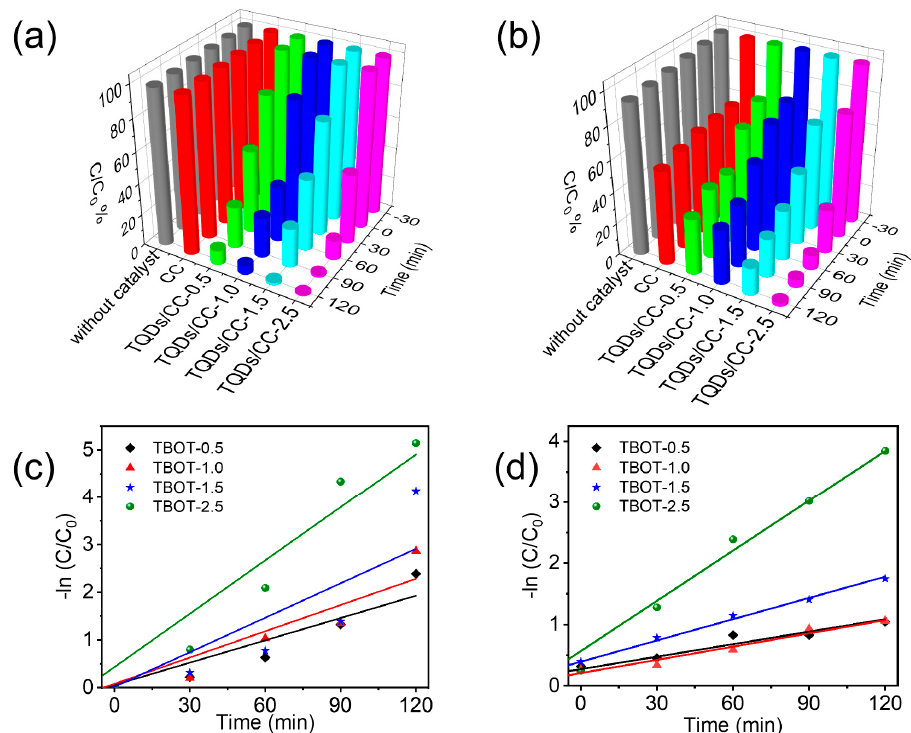
Figure 5. ( a ) Removal rate and pseudo-first-order kinetics curves ( c ) for MO under different TQDs/CC sample photodegradation. ( b ) Remove rate and pseudo-first-order kinetics curves ( d ) for RhB under different TQDs/CC photocatalyst photodegradation.